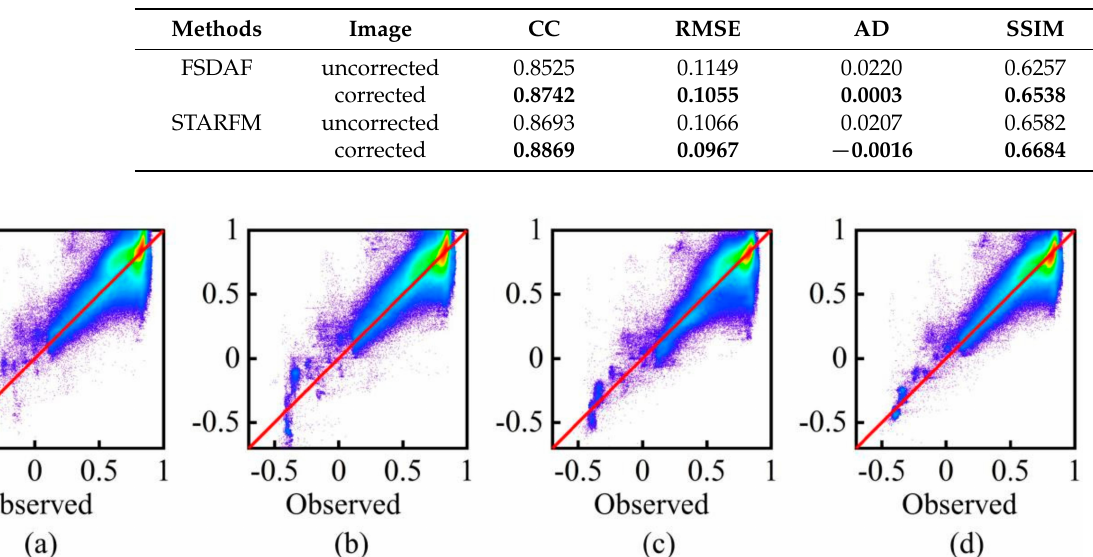
Table 3. Accuracy of STARFM- and FSDAF-predicted NDVI images before and after bias correction of input data in an area of western Jilin, China. Best results are marked in bold.